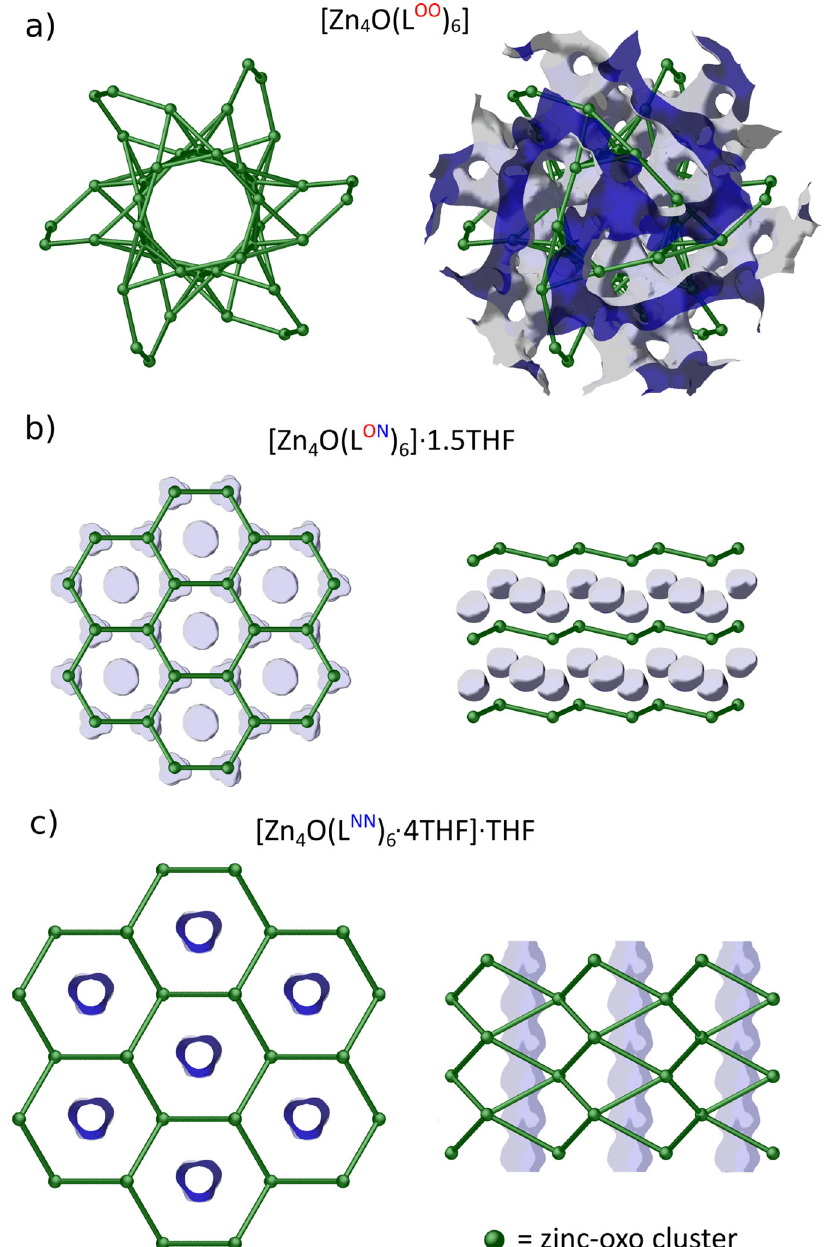
Fig. 4 Topology of the porous frameworks of the benzoate, benzamidate, and benzamidinate zinc-oxo clusters. Schematic representation of the supramolecular network formed by of [Zn 4 O(L OO ) 6 ] ( a ), [Zn 4 O(L ON ) 6 ] ( b ), and [Zn 4 O(L NN ) 6 ·4THF] ( c ) clusters with solvent-accessible surfaces of voids [blue and gray colors represent the interior and exterior pore surface, respectively]. In the case of benzamidate and benzamidinate derivatives, the voids are fi lled by THF